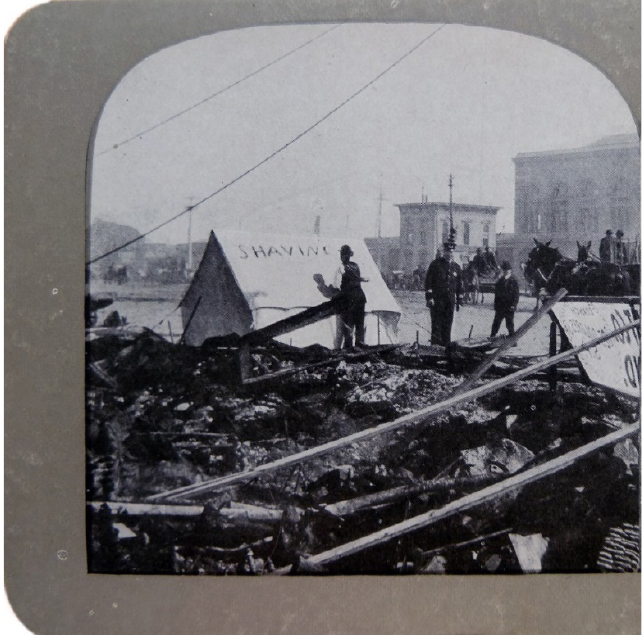
Figure 3: Left half of a 1906 stereograph with the title “True Grit—Barber painting sign on tent stretched on sidewalk of former